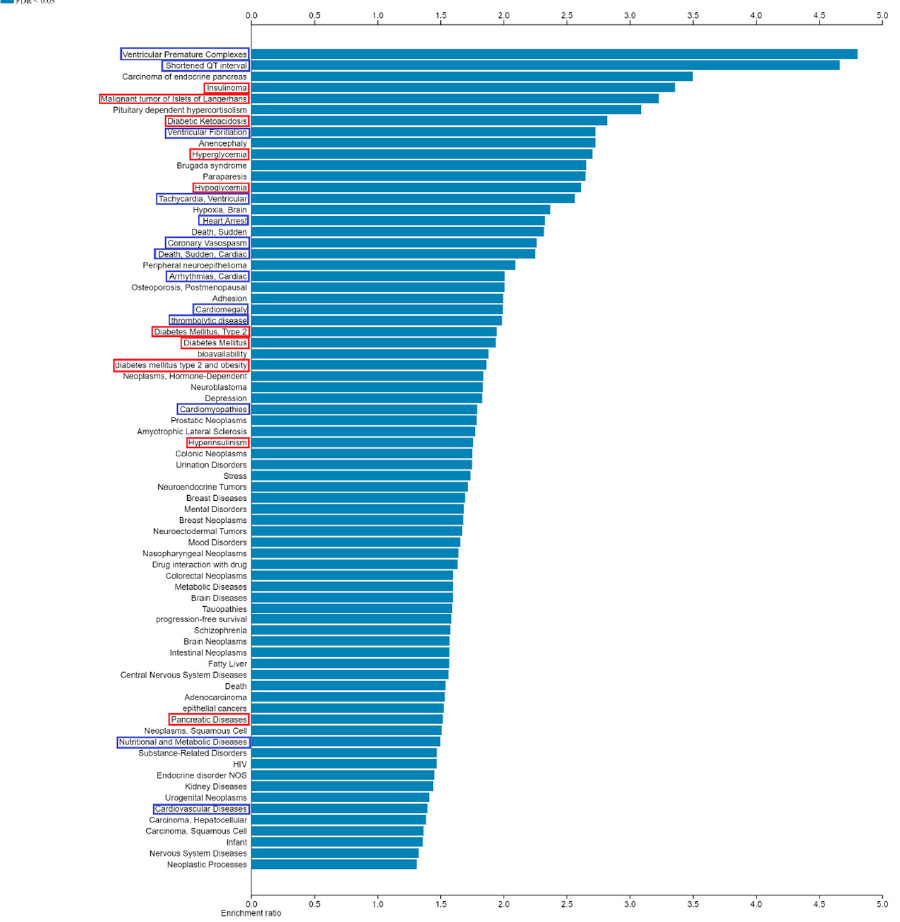
Figure 2. Enrichment of disease terms for IR key metagenes using GLAD4U with false discovery rate < 0.05 and number of genes in a category > 4.